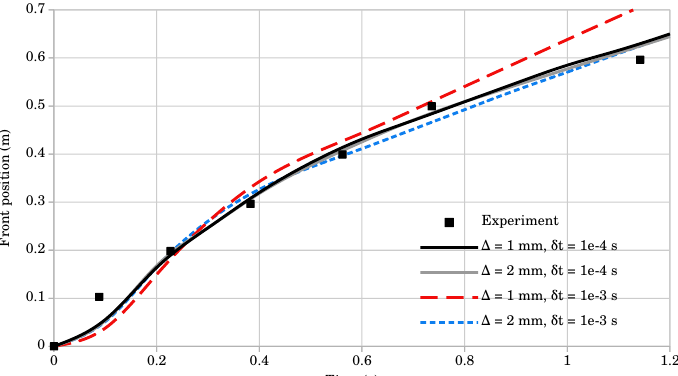
Figure 9. The evolution of mass front position for simulations with two node counts and time step sizes for the dam break test, compared to the experimental data.